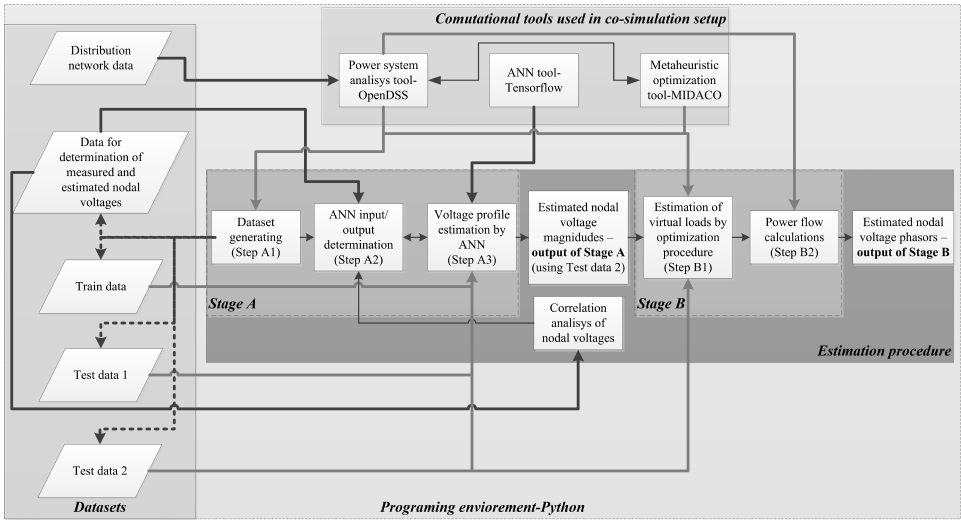
Figure 2. The workflow of the proposed framework for the voltage phasor profile